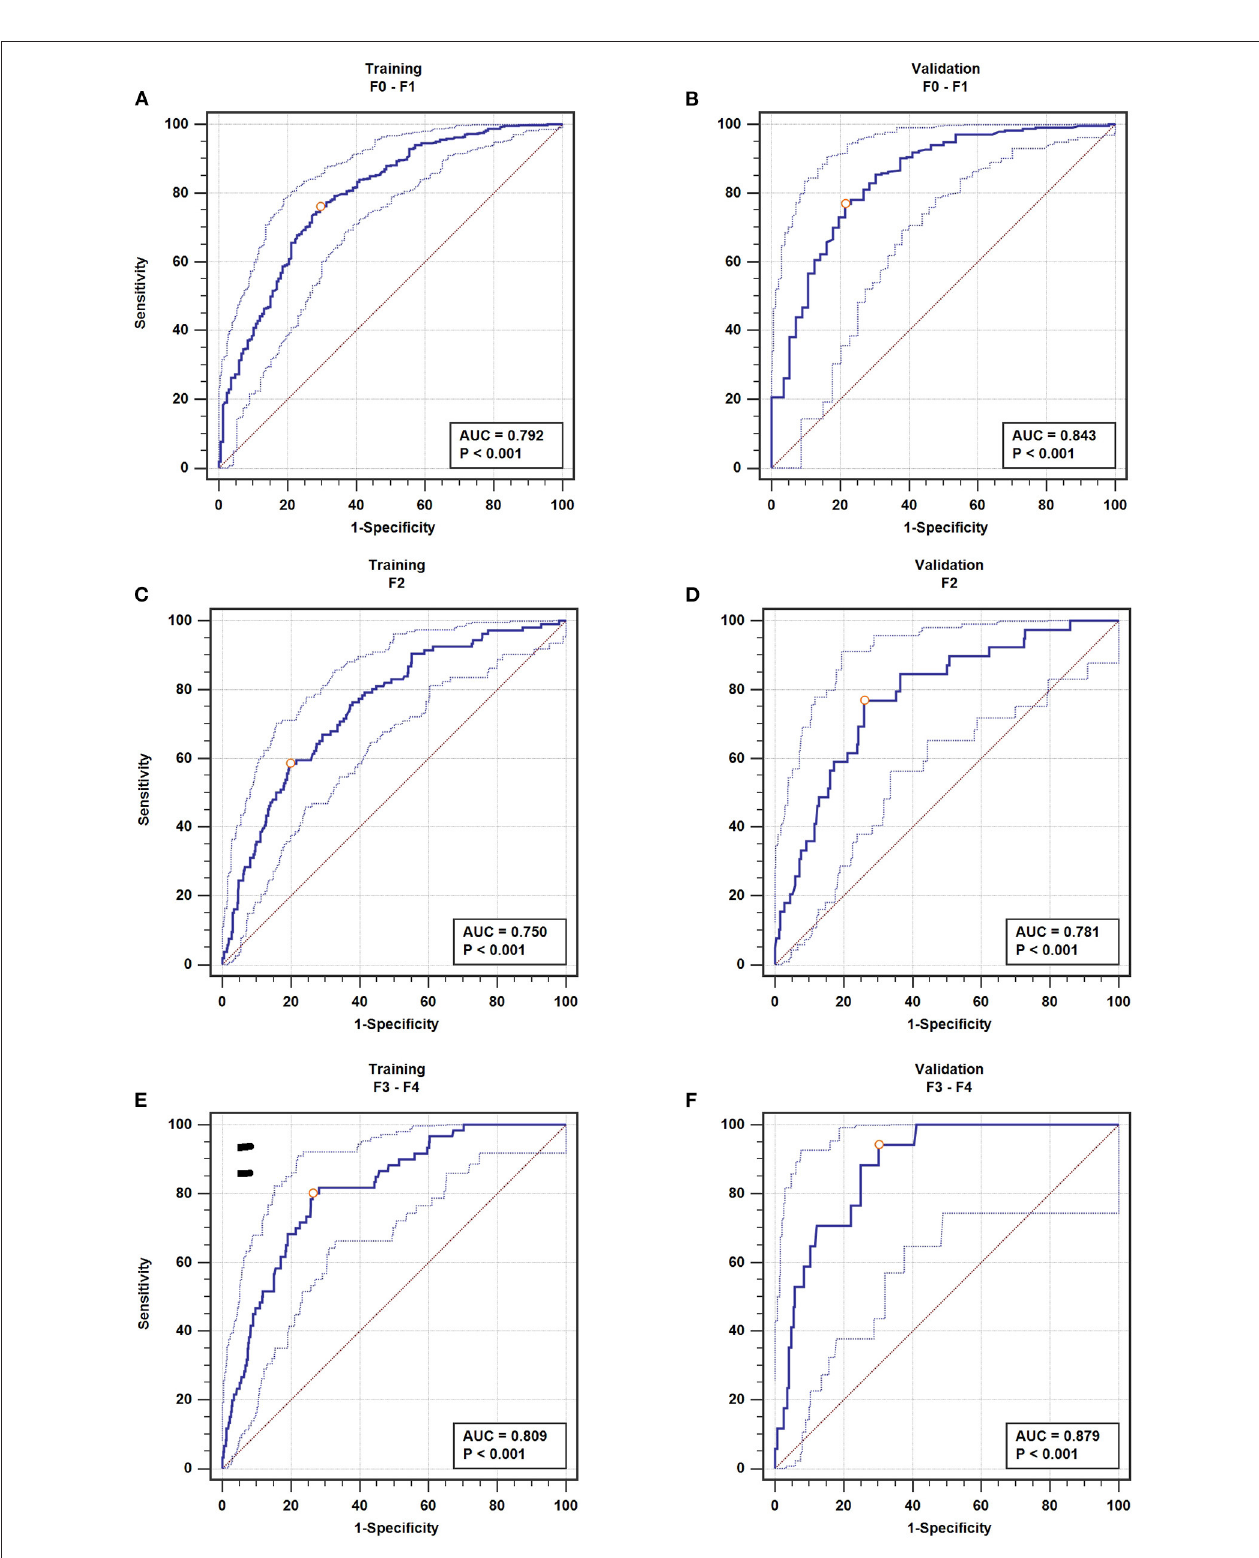
FIGURE 4 | The AUROC of fibrosis. nil-mild fibrosis (A) , moderate fibrosis (C) , severe fibrosis/cirrhosis (E) in the training set; nil-mild fibrosis (B) , moderate fibrosis (D) , severe fibrosis/cirrhosis (F) in the validation set.